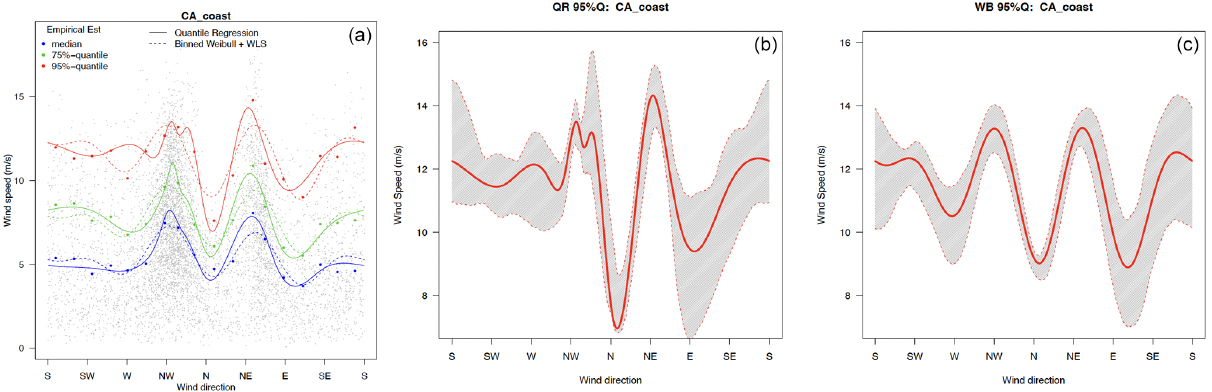
Figure 2. WRF-CCSM winter California (CA) coast data. (a) Fitted quantile curves (50th, 75th, and 95th quantiles) of the quantile and Weibull regression methods at the CA grid point, along with their bin-wise empirical estimates. (b) The 95% bootstrapped confidence intervals of the 95th quantile (gray shaded area) and its point estimate (red curve), using periodic quantile regression. (c) Same as panel (b) but using Weibull